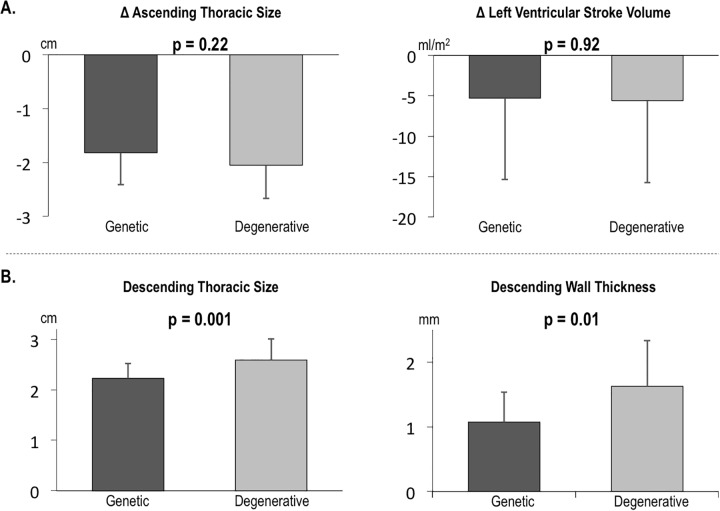
Aortic morphology and left ventricular performance indices between AA subtypes.(A) Note similar changes in ascending aortic size and LV stroke volume between groups, without significant differences either pre- or post-operatively. (B) Conversely, both pre-operative descending aortic size and wall thickness were greater among patients with degenerative AA. Data shown as mean ± standard deviation.